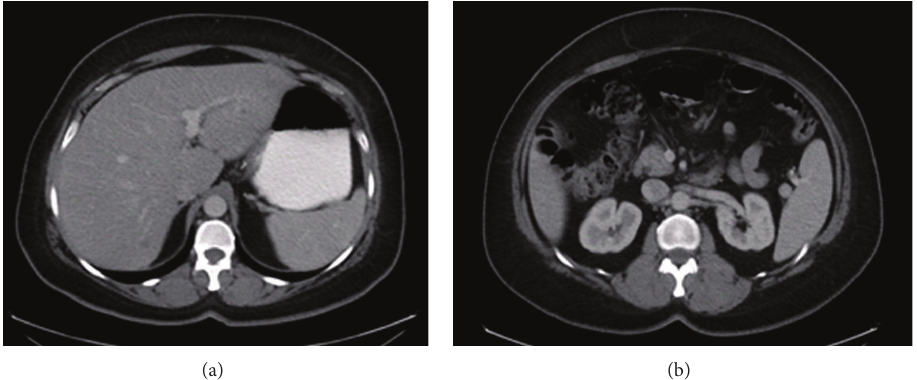
Figure 6: Heterogeneous liver with multiple low attenuating foci and a soft tissue density seen in small bowel mesentery.